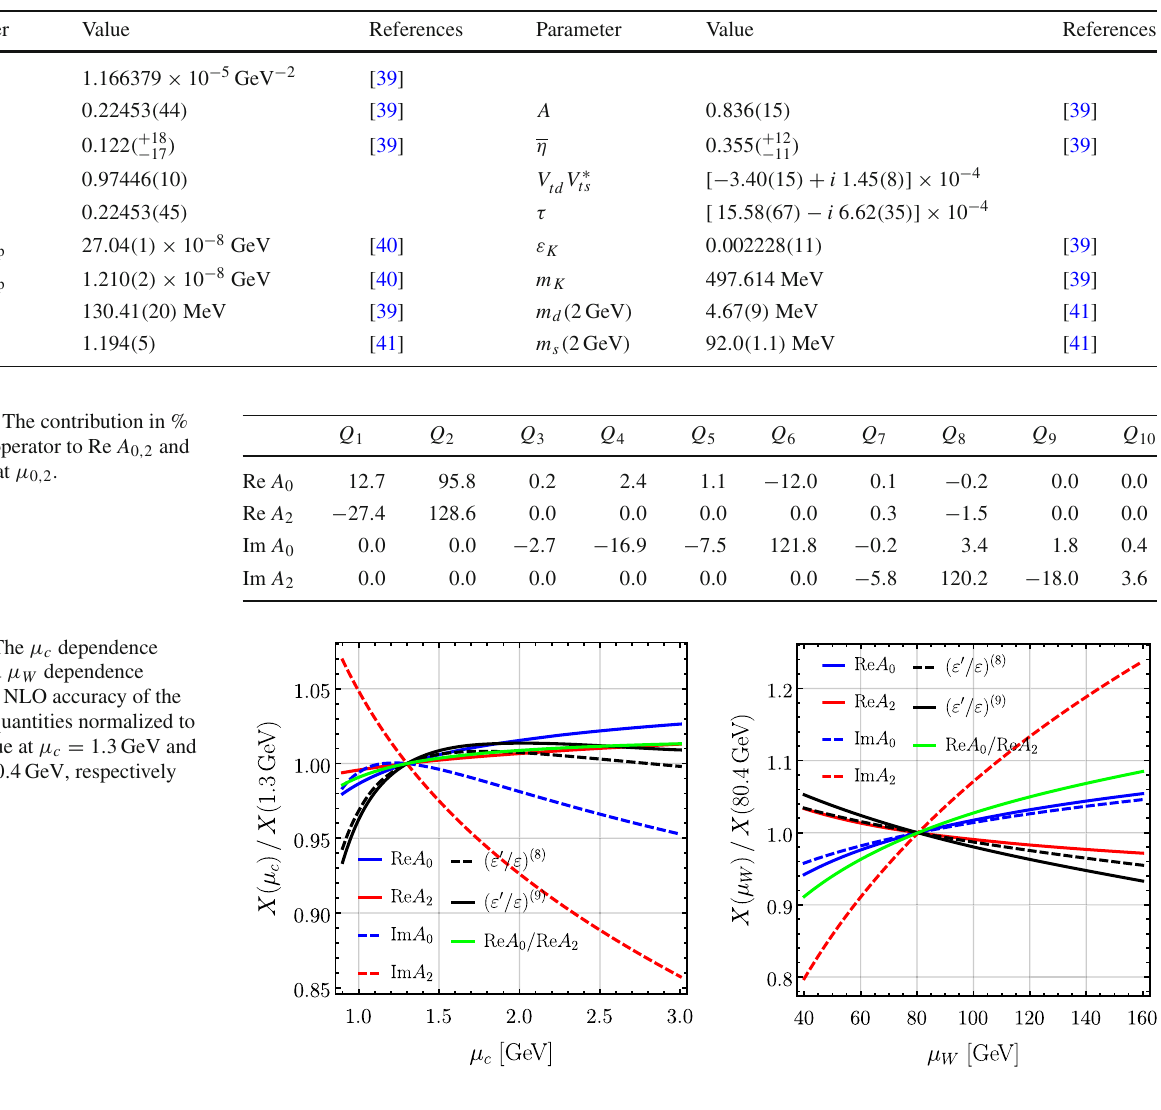
Table 2 Numerical input: The CKM elements and combinations thereof and the uncertainties are derived from Wolfenstein parameters from PDG 2019. The experimental results for K → ππ amplitudes